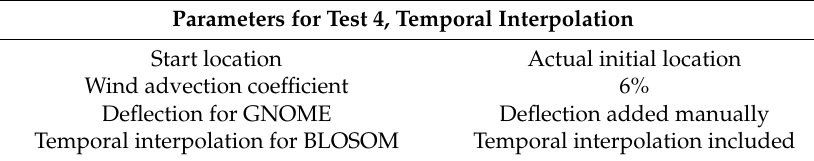
Table 7. Parameters for test 4, temporal interpolation.